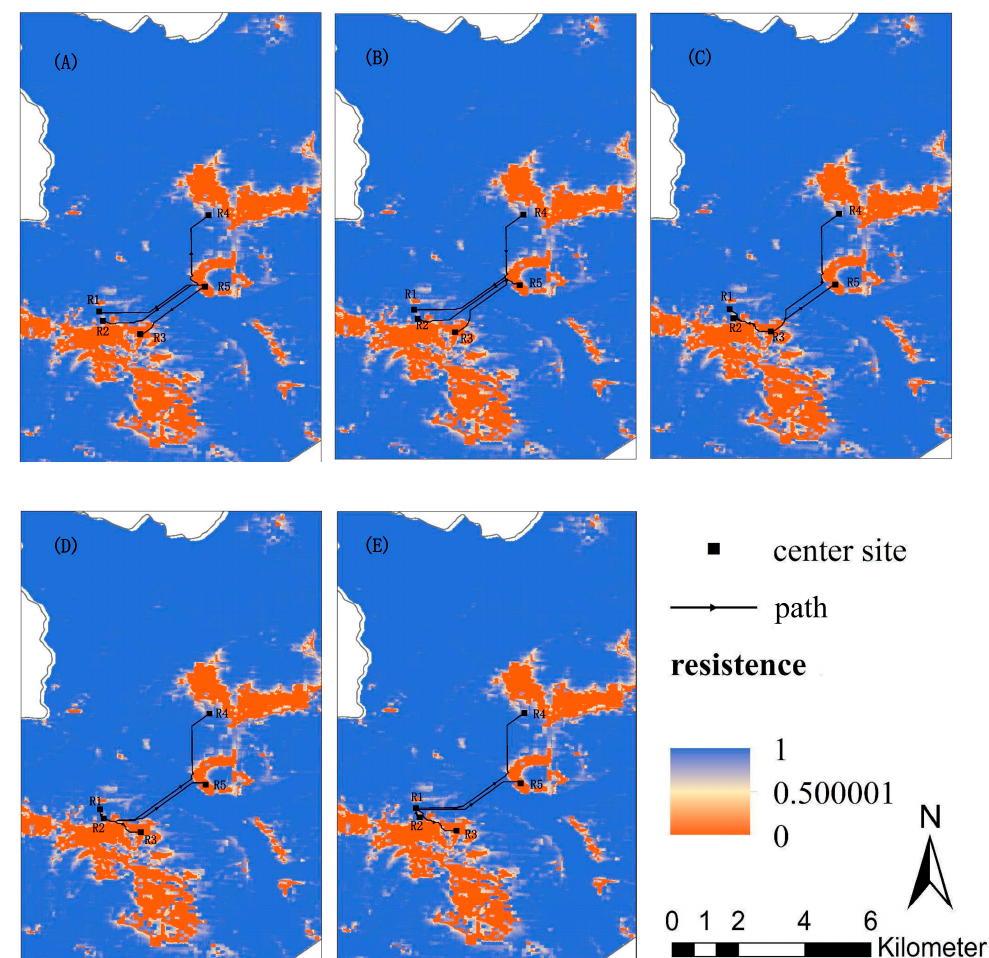
Figure 7. The least-cost paths among main distribution areas: ( A ) The least-cost path from distribution R5 to other distributions; ( B ) Distribution R4 to other distributions; ( C ) Distribution R3 to other distributions; ( D ) Distribution R2 to other distributions; ( E ) Distribution R1 to other distributions.